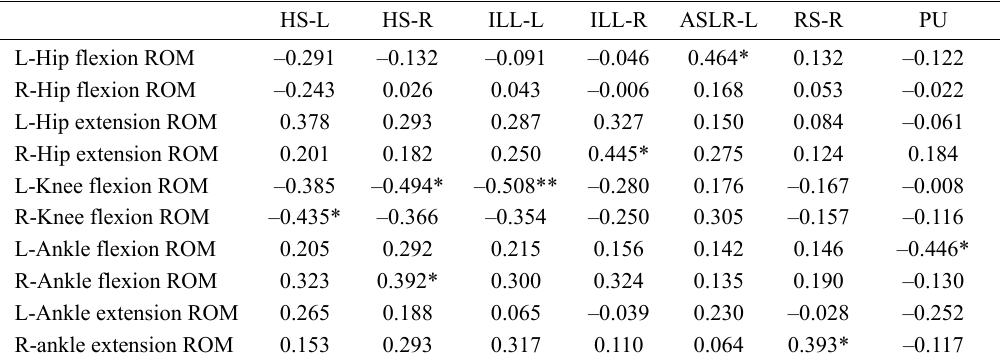
Table 5. Correlation between FMS test results and lower limb joint range of motion (n =